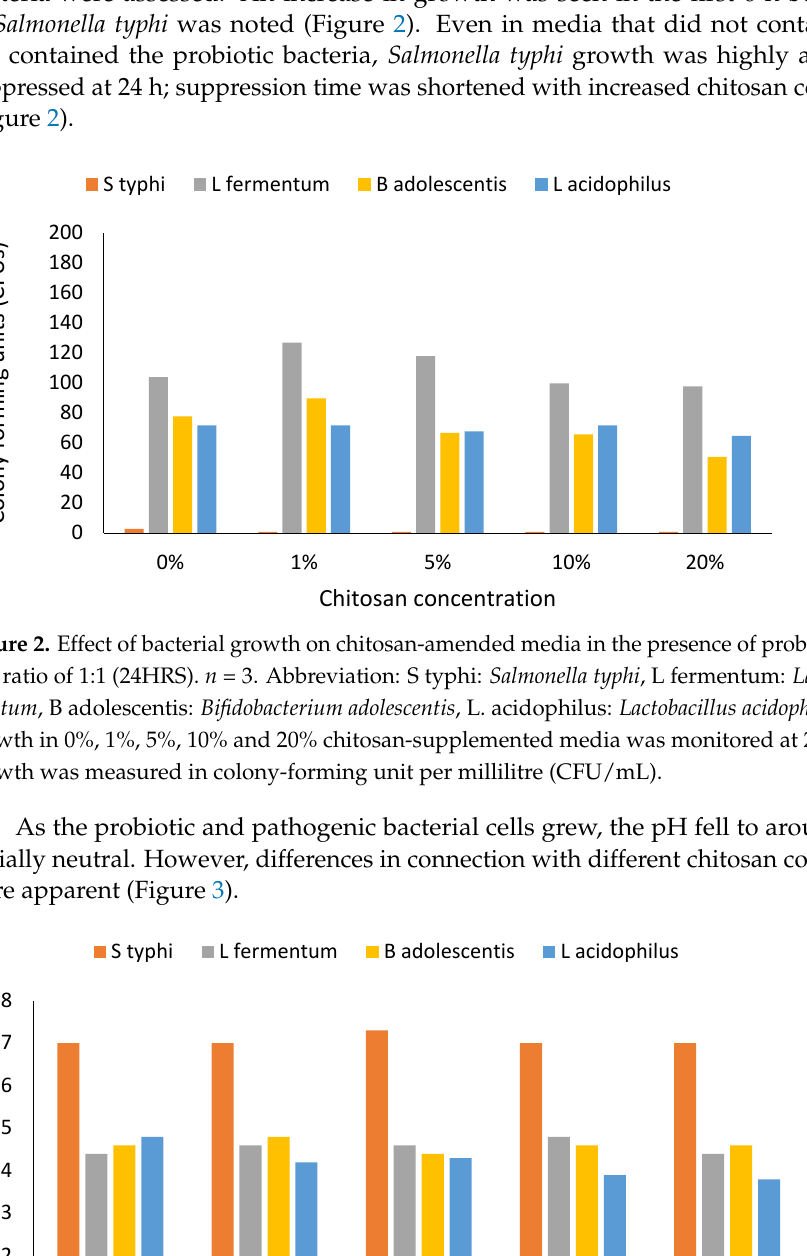
Figure 1. Growth of bacterial cells in chitosan-amended media (24 h). n = 3. Abbreviation: S